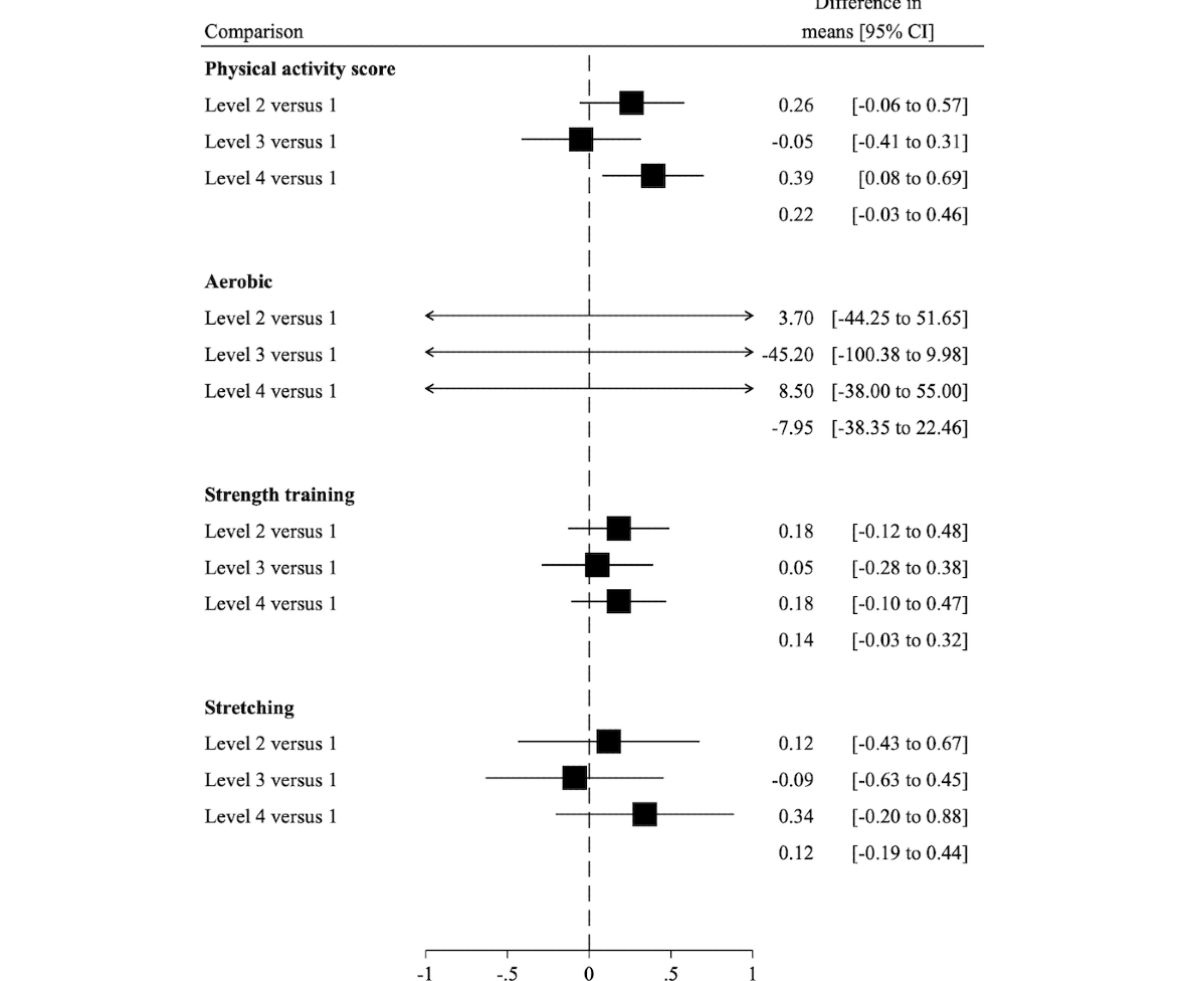
Figure 4. Difference in mean change in an overall physical activity score (range 0-6) and types of physical activity (minutes per week of aerobic; sessions per week of strength training and stretching) from baseline to 3 months, comparing intervention levels 2 to 4 with level 1. Higher scores indicate more physical activity. These secondary analyses were performed among the 152 men with complete data on physical activity at 0 and 3